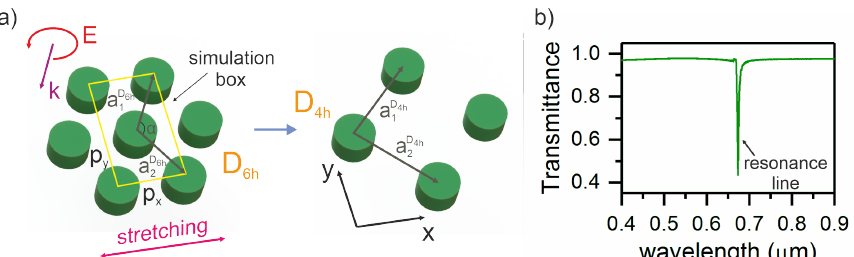
Figure 1. ( a ) Schematic of a two-dimensional triangular grating of nanodisks and ( b ) transmittance spectra of the structure calculated by the finite difference time domain